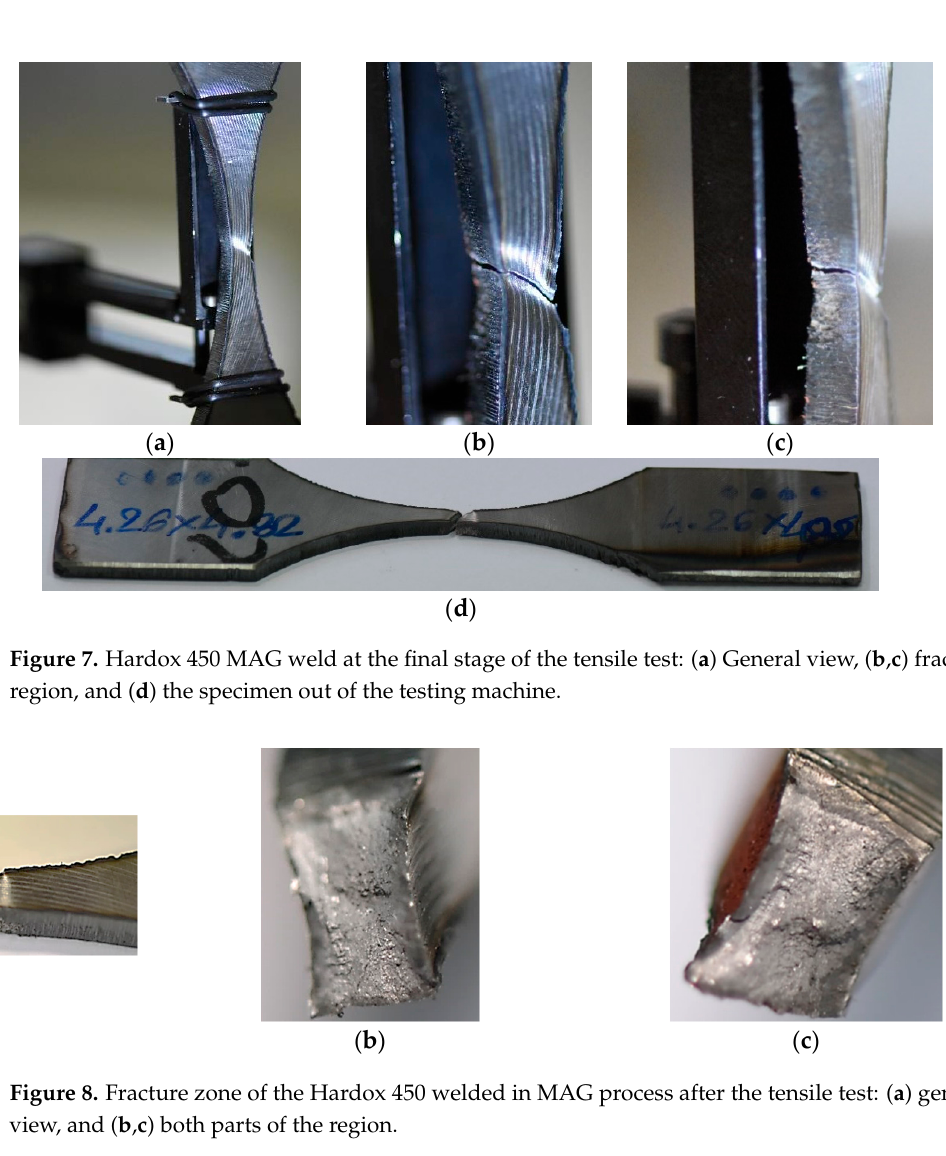
Table 7. Proportion between the fatigue limit and the mechanical parameters of the Hardox 450 MAG weld.